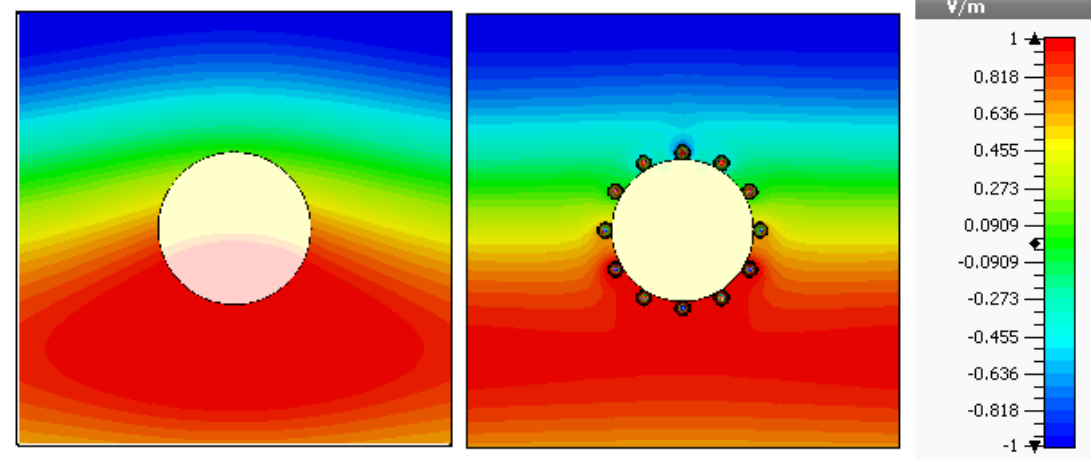
Figure 10. Magnitude of the y -component of the electric field on a plane perpendicular to the axis of the cylinder and passing for its center both in the uncloaked ( left ) and cloaked case ( right